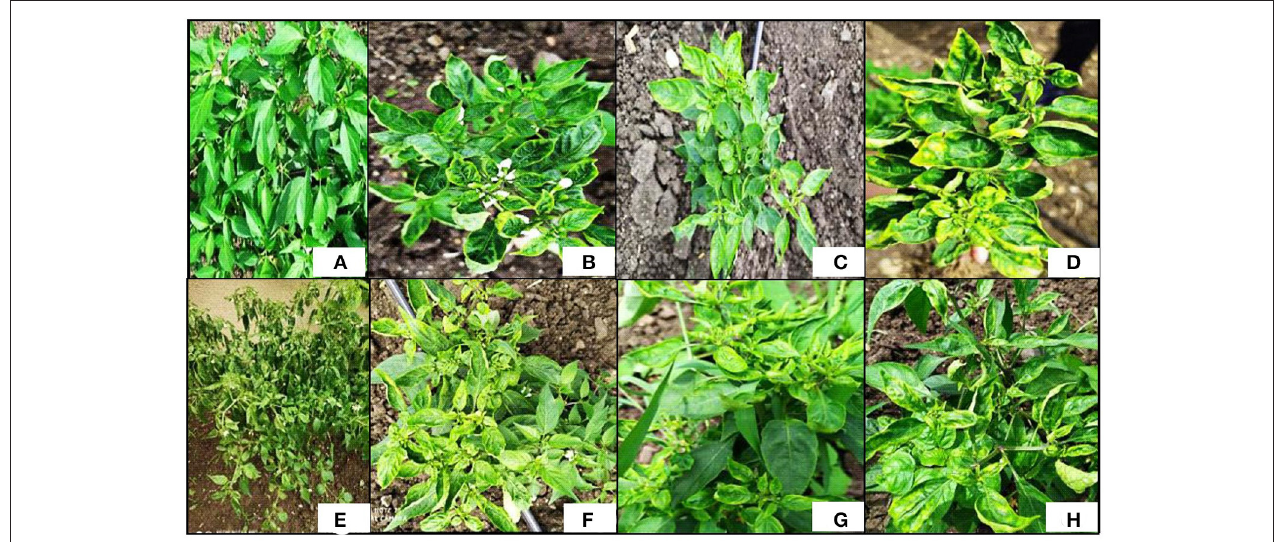
TABLE 1 | Distribution of begomoviruses associated with ChiLCD in Indian subcontinent.